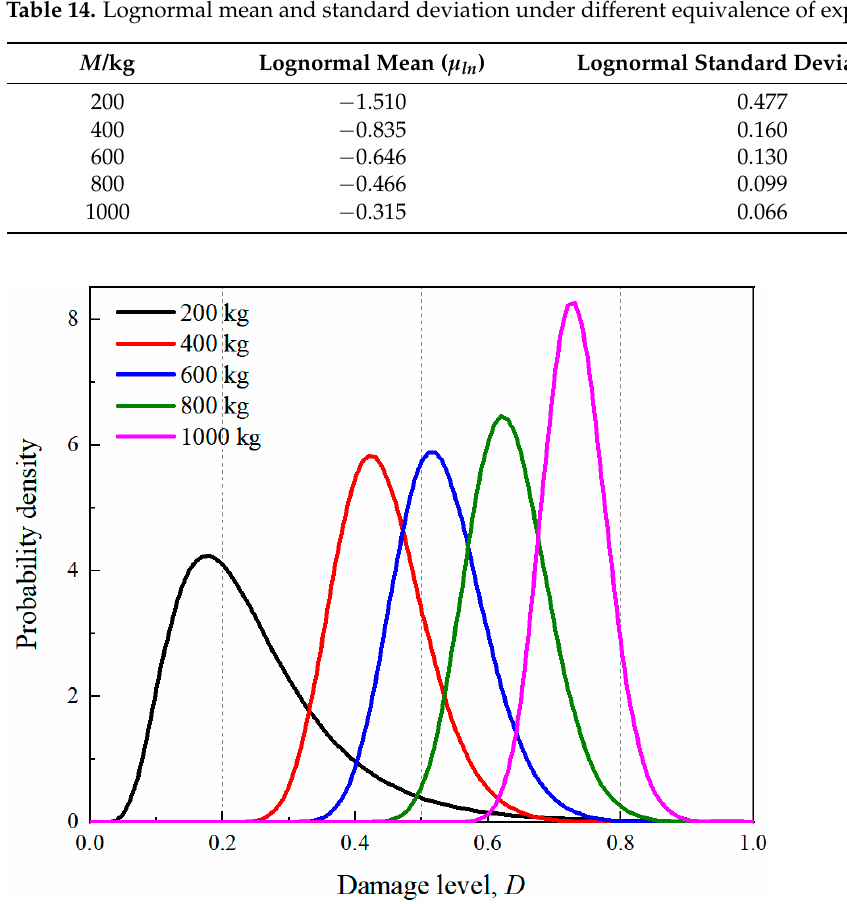
Figure 16. Probability density function of damage index for the tunnel under different equivalence of